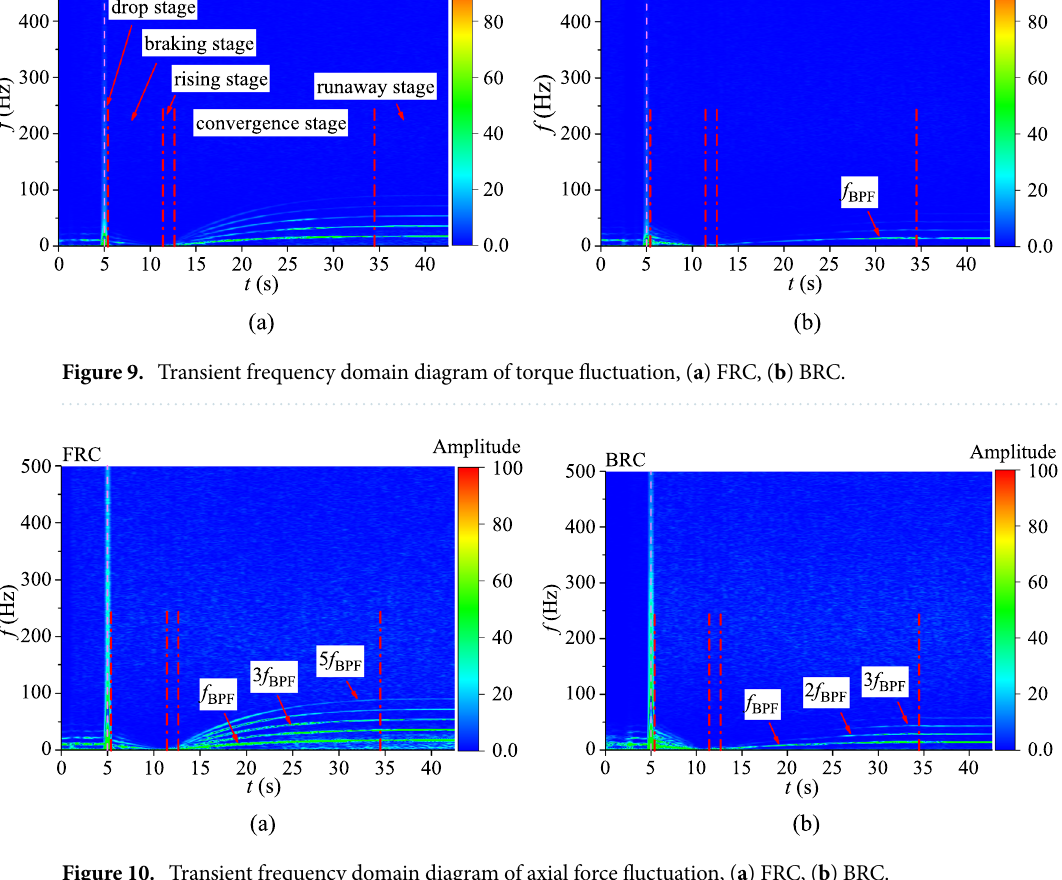
Figure 10. Transient frequency domain diagram of axial force fluctuation, ( a ) FRC, ( b )